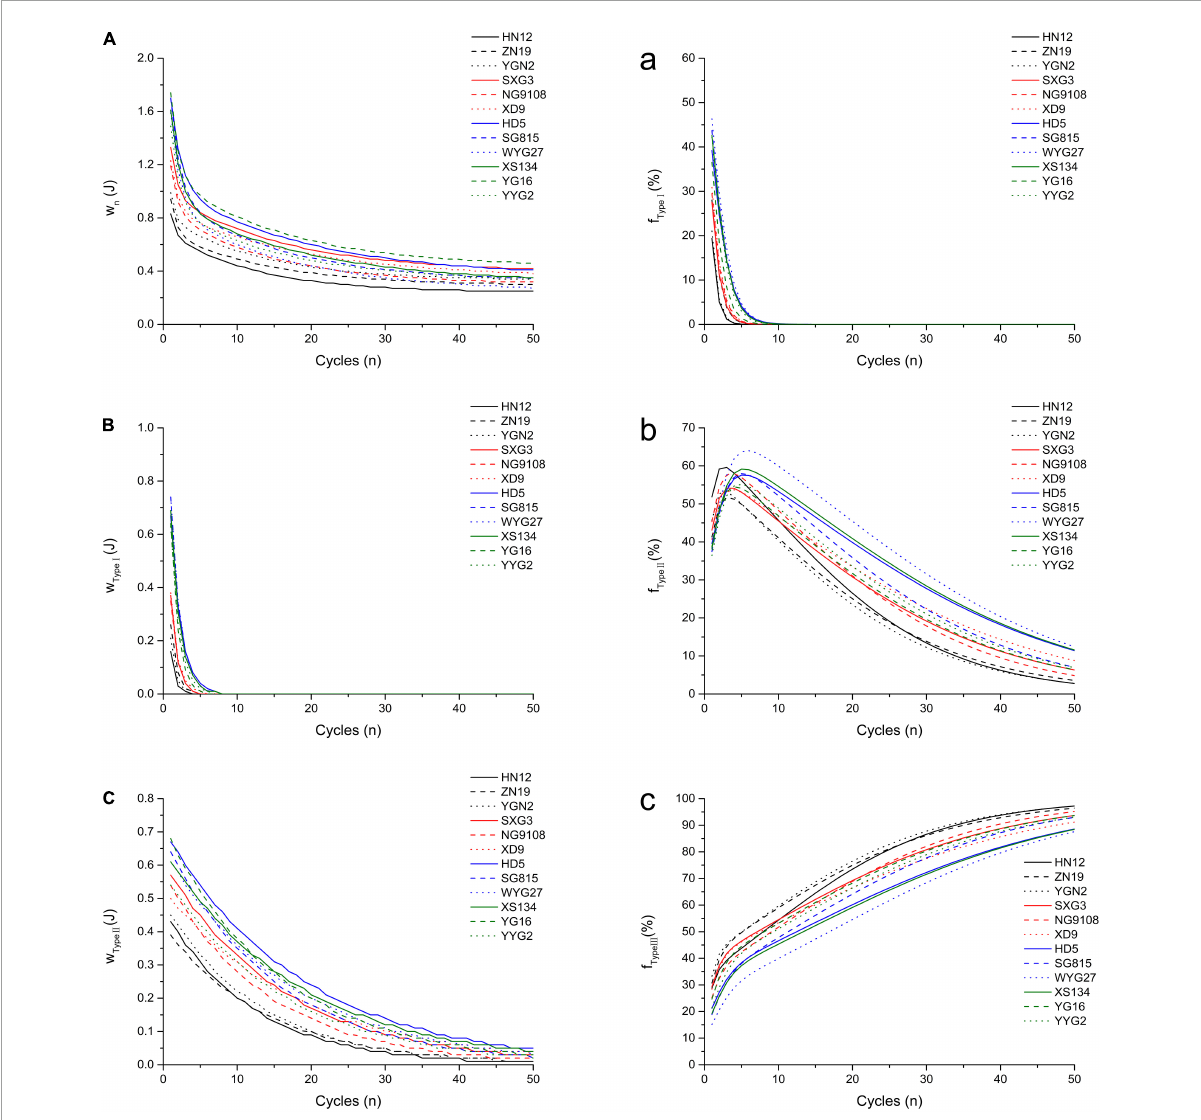
FIGURE2 Simulated oral processing of cooked japonica rice. The fitted work of three type structures during each extrusion cycle (A) Type I; (B) Type II; (C) Type III. The fraction of the work contributed to the breakdown of different structures per extrusion cycle (a) Type I; (b) Type II; (c) Type